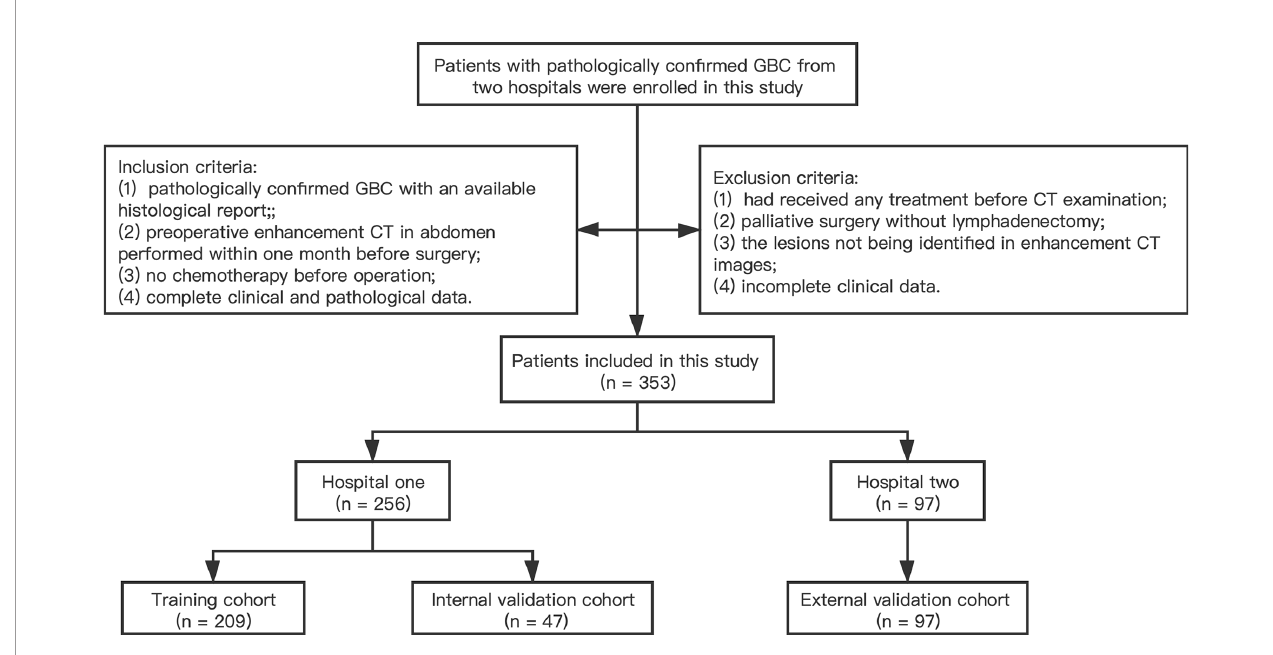
FIGURE 1 | Recruitment pathway of patients.